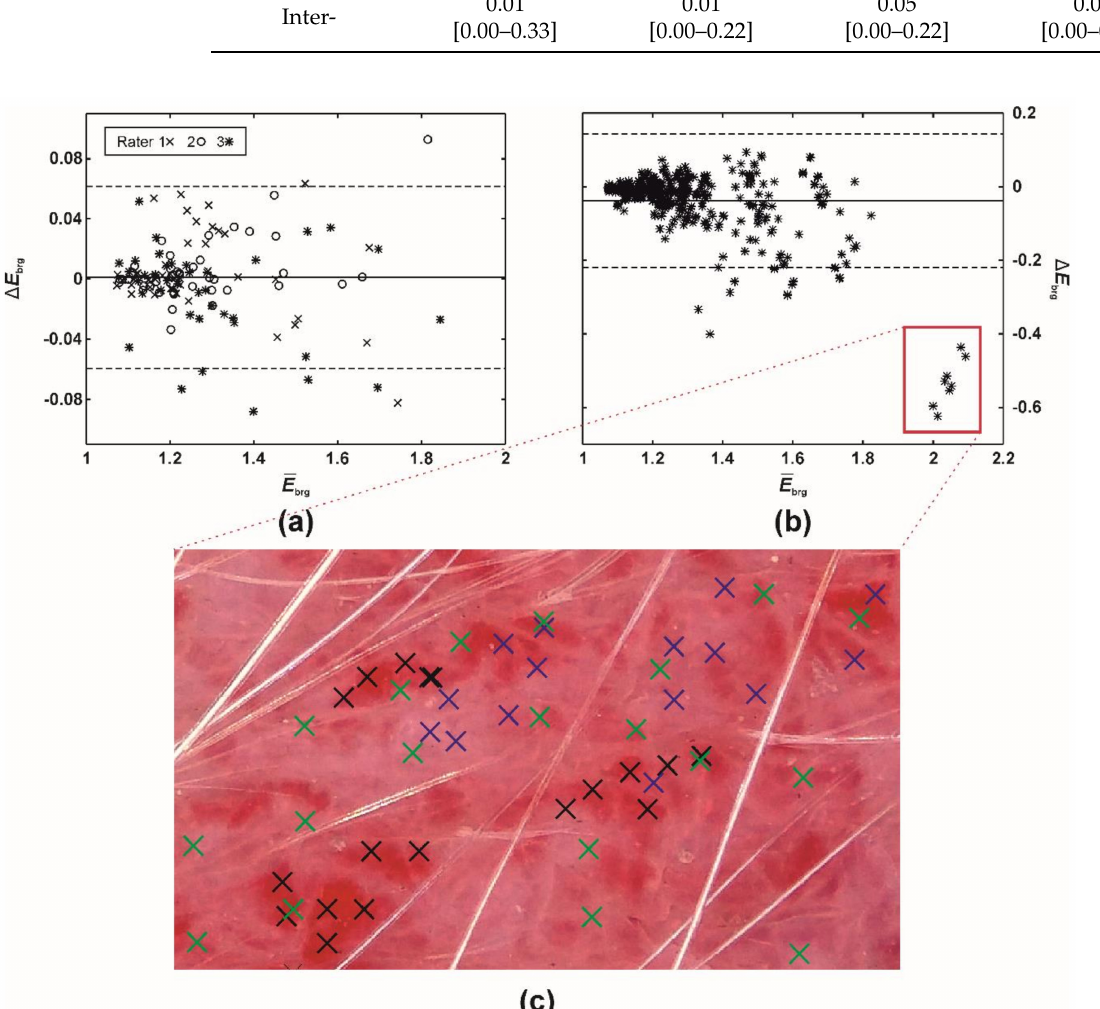
Figure 5. A difference (Bland-Altman) plot of EI BRG misestimates between ( a ) a single (intra-) and ( b ) multiple raters (inter-rater absolute agreement). The full and two dashed lines represent the difference mean and 95% limits of agreement (i.e., 1.96 × of SD), respectively. ( c ) Execution of PT (60 pixels), ISM. Blue (rater 1), green (rater 2), and black crosses (rater 3) mark the pixels selected by the three